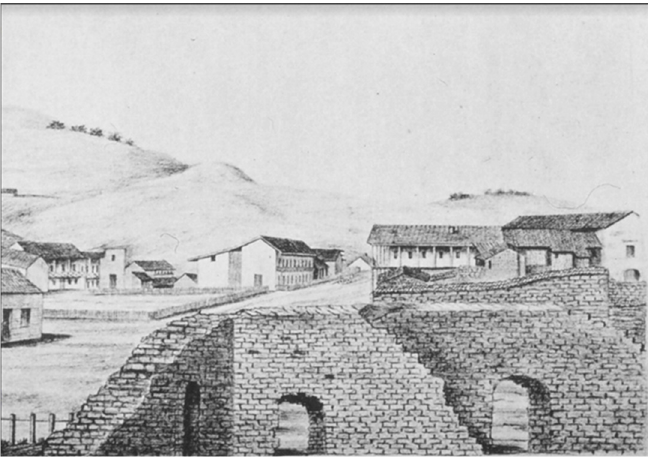
Figure 17. Adobe ruins at San Juan Bautista, 1856 [1].